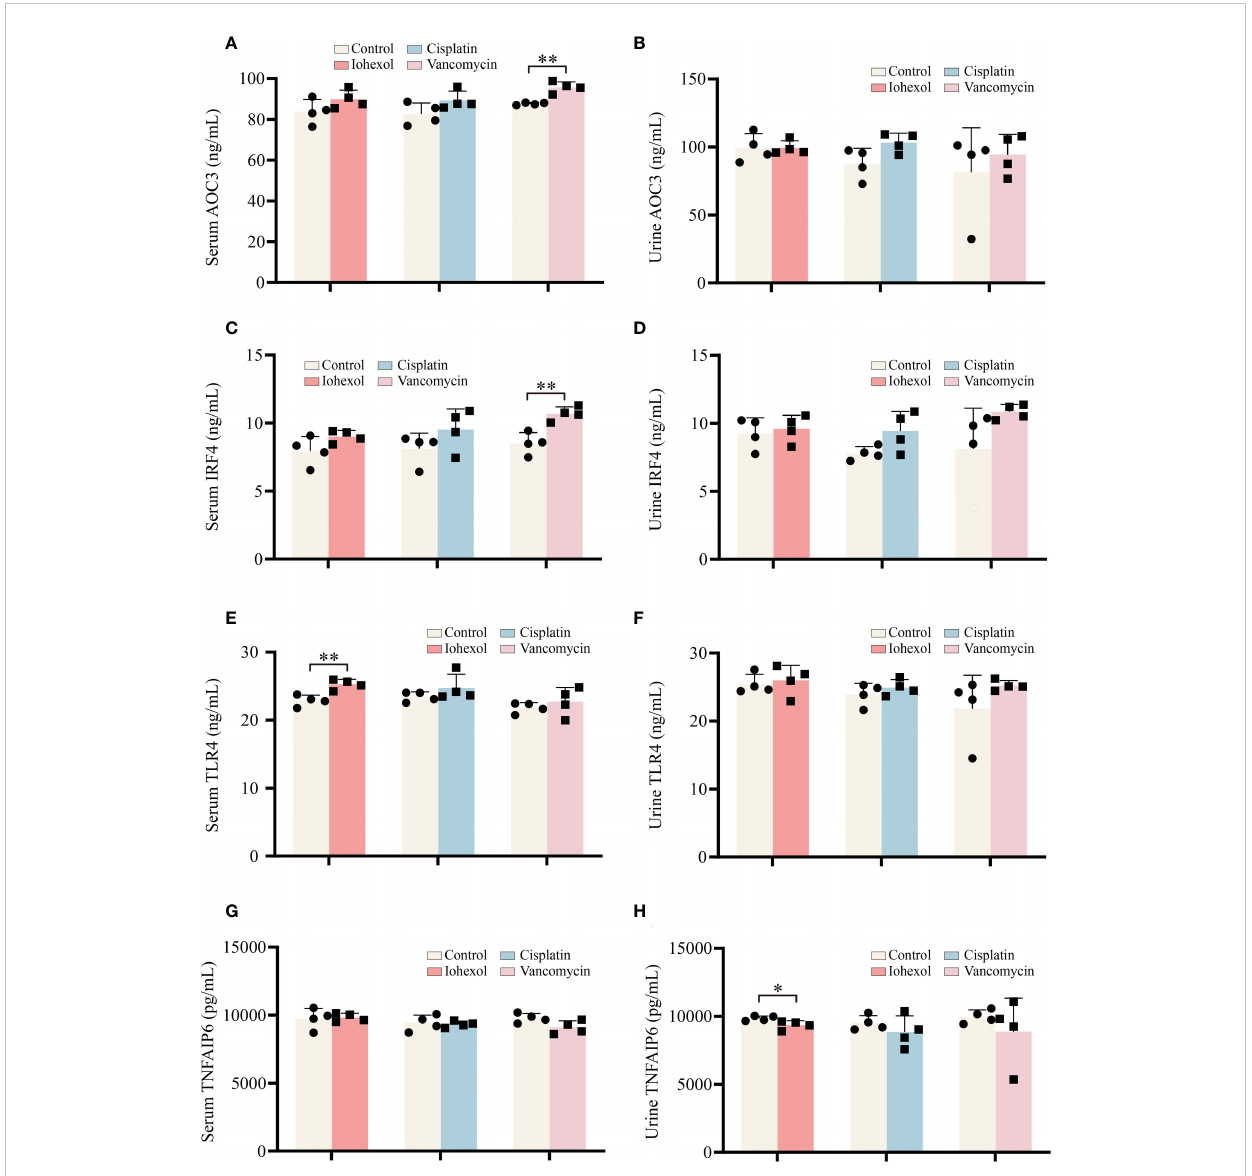
FIGURE 8 Validation of the hub genes in serum and urine of DI-AKI mice. (A, B) AOC3 protein levels in serum and urine of DI-AKI mice. (C, D) IRF4 protein levels in serum and urine of DI-AKI mice. (E, F) TLR4 protein levels in serum and urine of DI-AKI mice. (G, H) TNFAIP6 protein levels in serum and urine of DI-AKI mice. Compared with the control group, * p < 0.05; ** p <